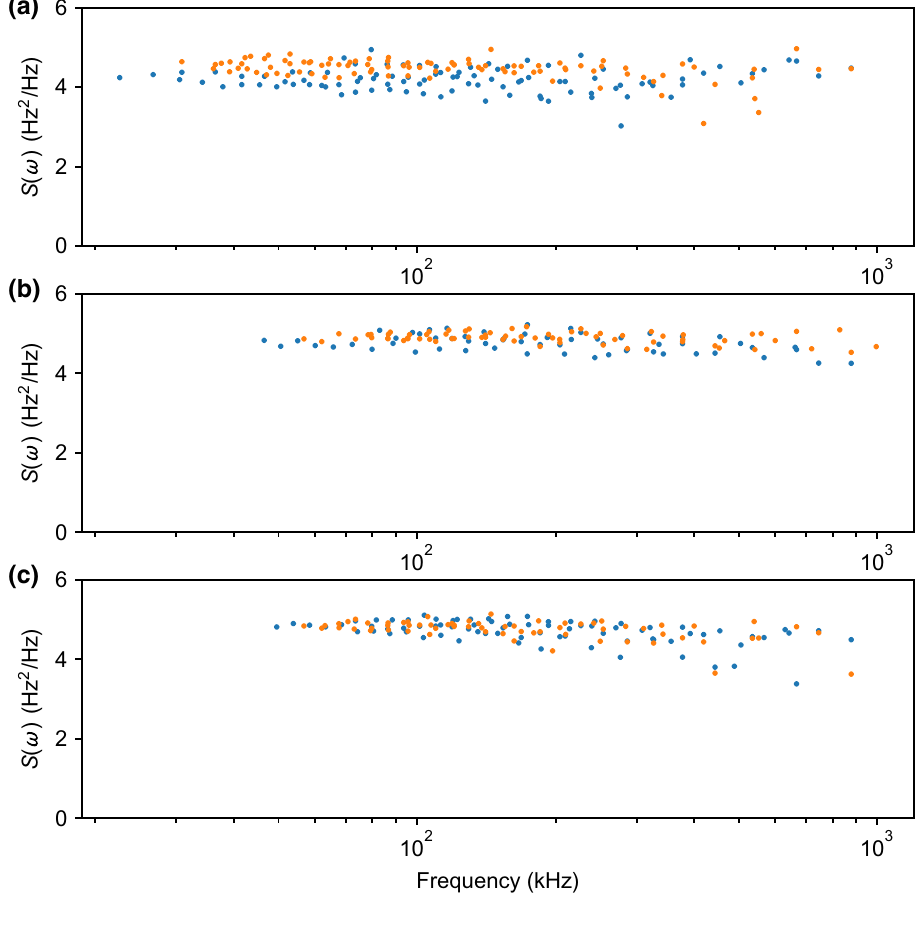
FIG. 7. Spectral decomposi- tion for a sample of NV centers in Sample 8 before (blue) and after (orange) 650 ◦ C vacuum anneal. Depths of NV centers